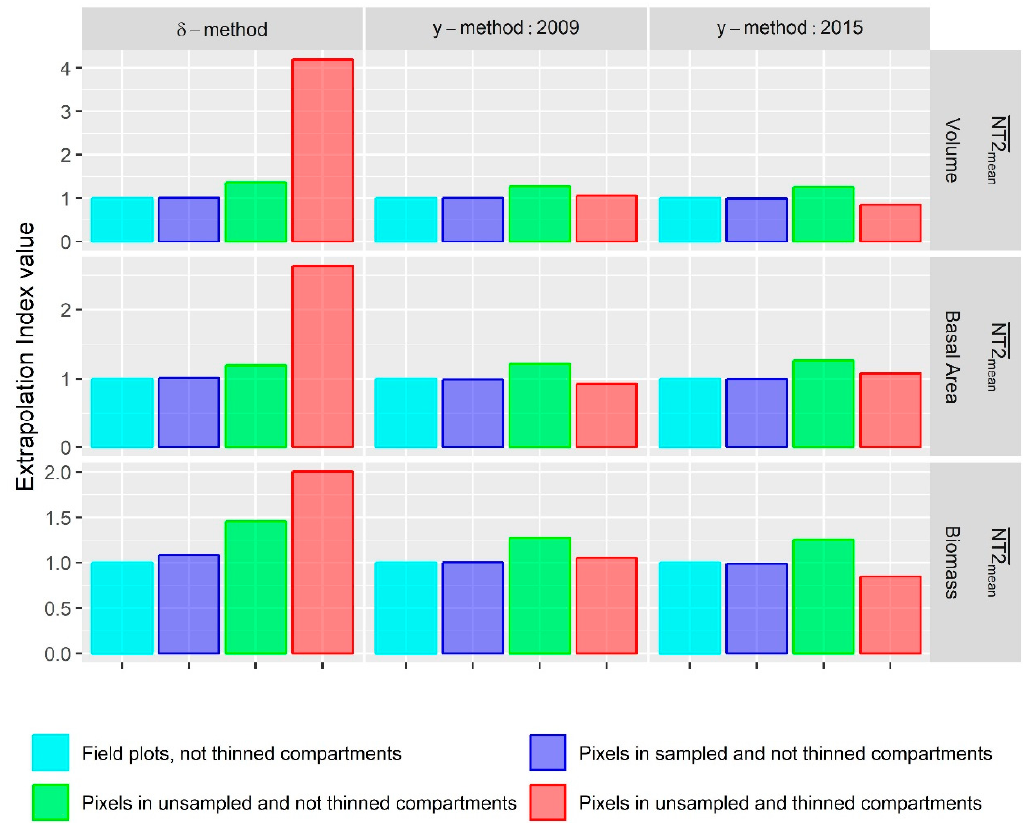
Figure A3. Indexes of extrapolation. Average of Mesgaran’s novelty index relative to the mean, NT 2 mean , for the sampled and not thinned stands (dark blue), unsampled stands not thinned (green) and unsampled and thinned stands (red). The value of this index for the field plots (light blue) provides the baseline value (i.e., the value observed for the sample of field plots).